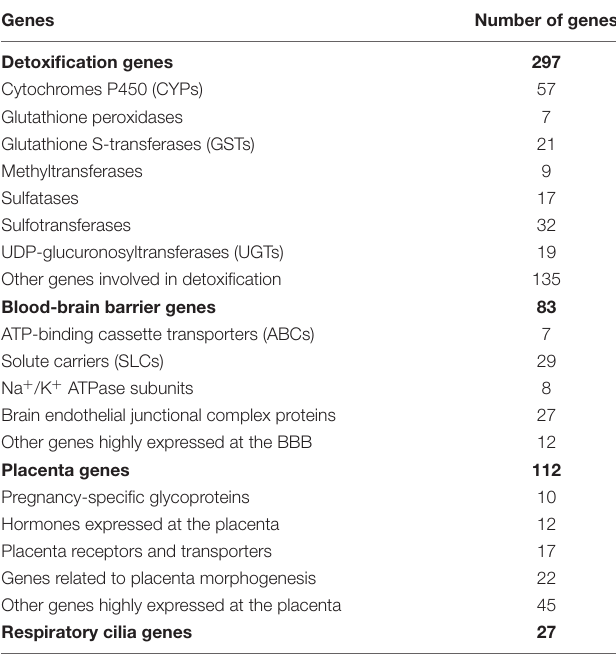
TABLE 1 | Main classes of genes involved in detoxification and permeability regulation of the BBB, placenta or respiratory cilia (XenoReg genes).